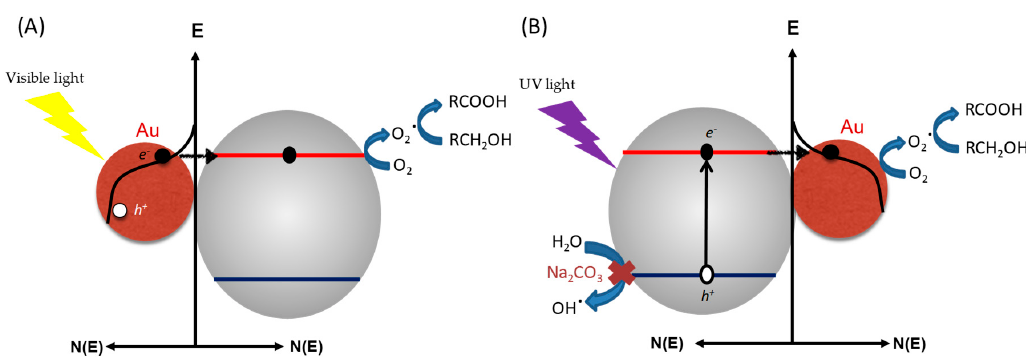
Figure 3. Proposed reaction mechanism for the photo-induced biomass derivatives’ transformation by using an Au/TiO 2 photocatalyst under visible ( A ) and UV ( B ) irradiation proposed by Zhou et al. [42]. Simultaneously to this work, Omri et al.